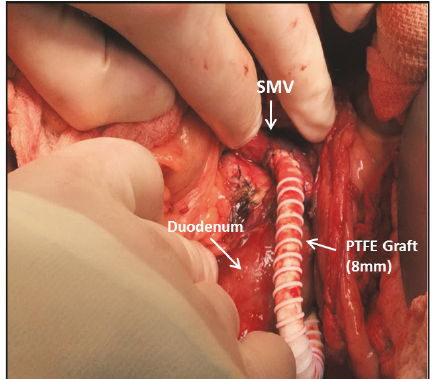
Figure 3: Intraoperative photo demonstrating the mesocaval bypass. An 8mm ringed polytetrafluoroethylene (PTFE) graft was usedtoshuntbloodflowfromtheproximalsuperiormesentericvein (SMV) to the infrarenal